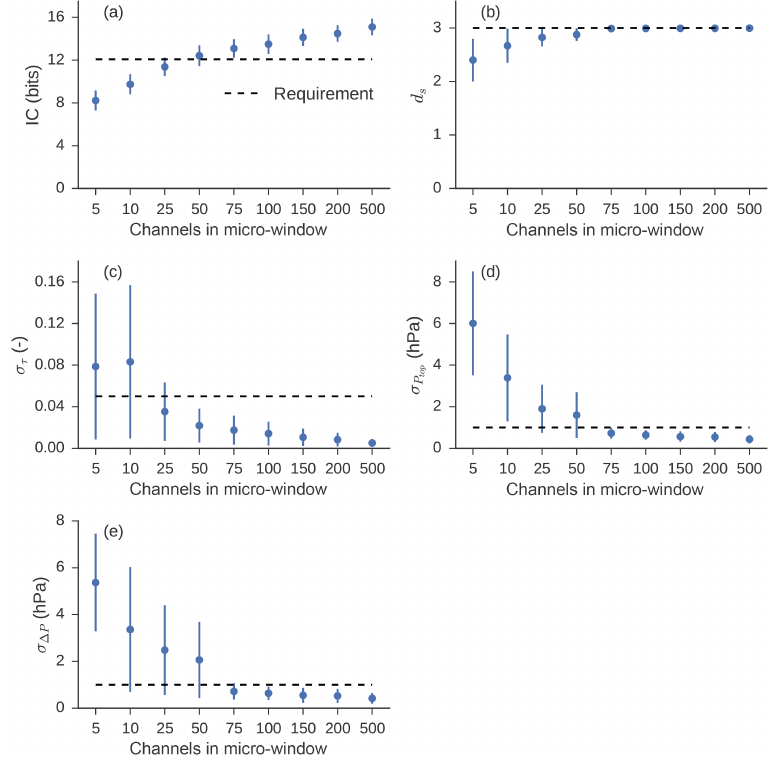
Figure 5. Range of performance for best-located micro-window of each size. The point represents the central value and the lines the full range of the 216 outputs covering each sounding position, meteorology and cloud case. Note that the x axis is non-linear. (a) Information content in bits and (b) degrees of freedom for signal. Panels (c–e) show square root of diagonal covariance matrix elements: (c) cloud optical depth, (d) cloud-top pressure and (e) cloud pressure thickness. Dashed lines represent selected retrieval requirements.